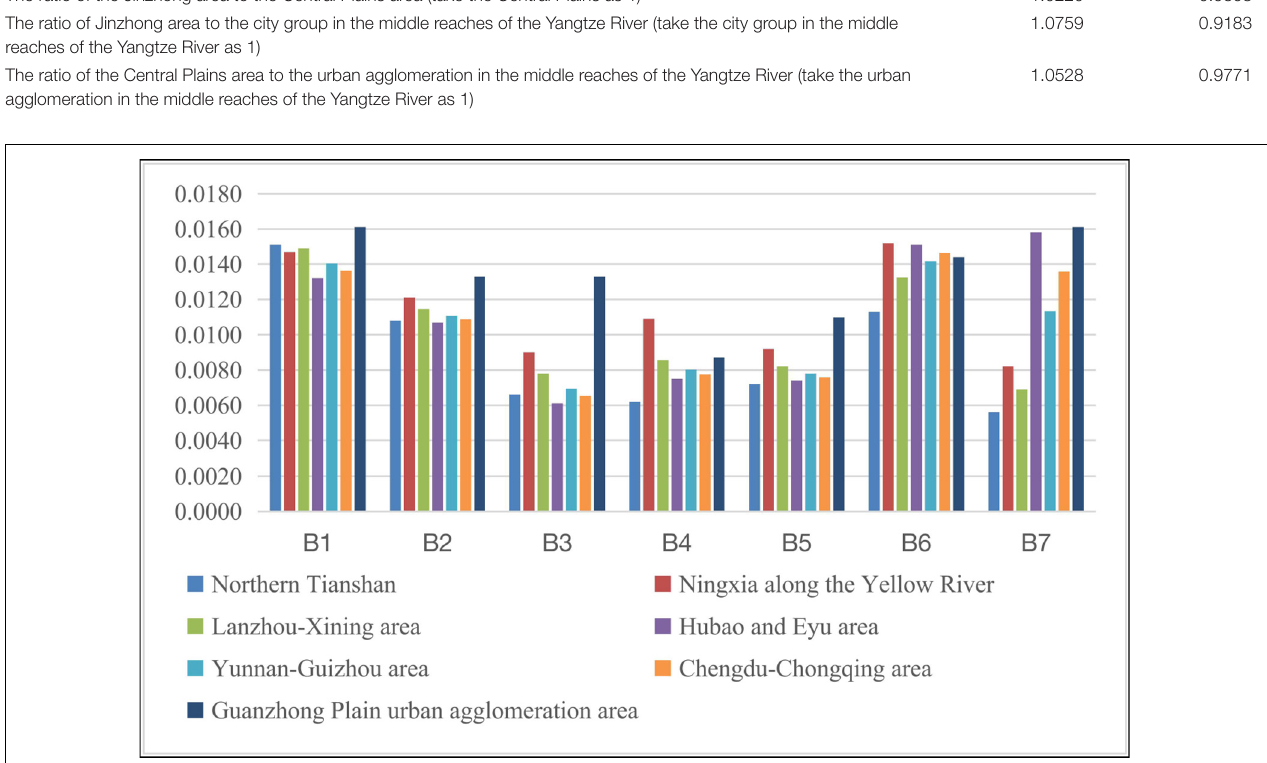
FIGURE 7 | Social development level of each indicator within the western region during 2011–2015.